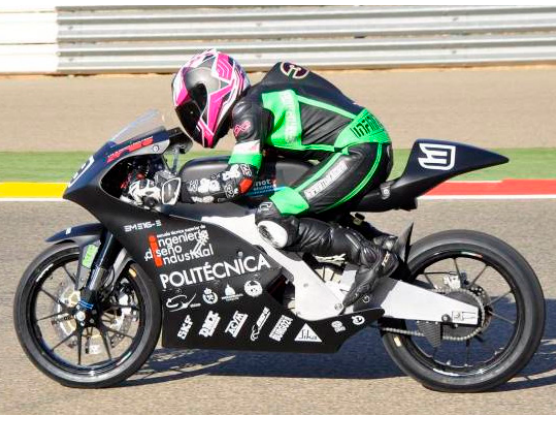
Figure 15. EME 16E during the MotoStudent competition.